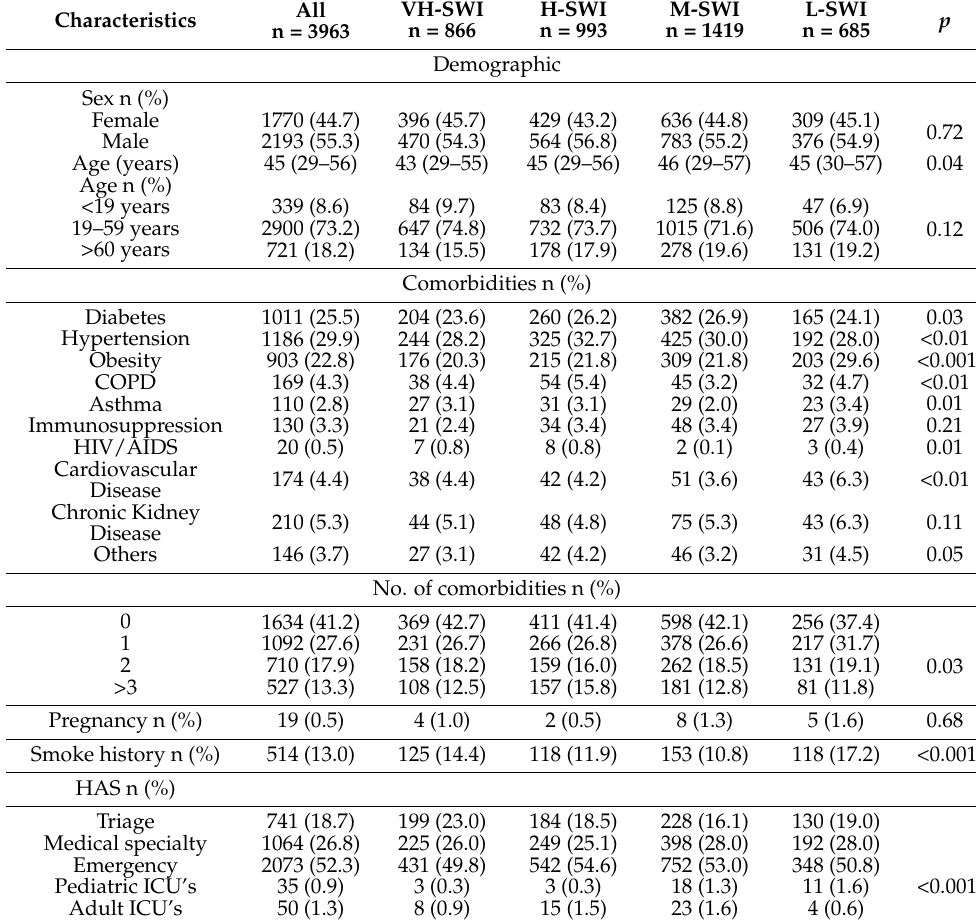
Table 1. Epidemiological profile and hospital admission service of total sample and stratified by Social Welfare Index categories of patients with